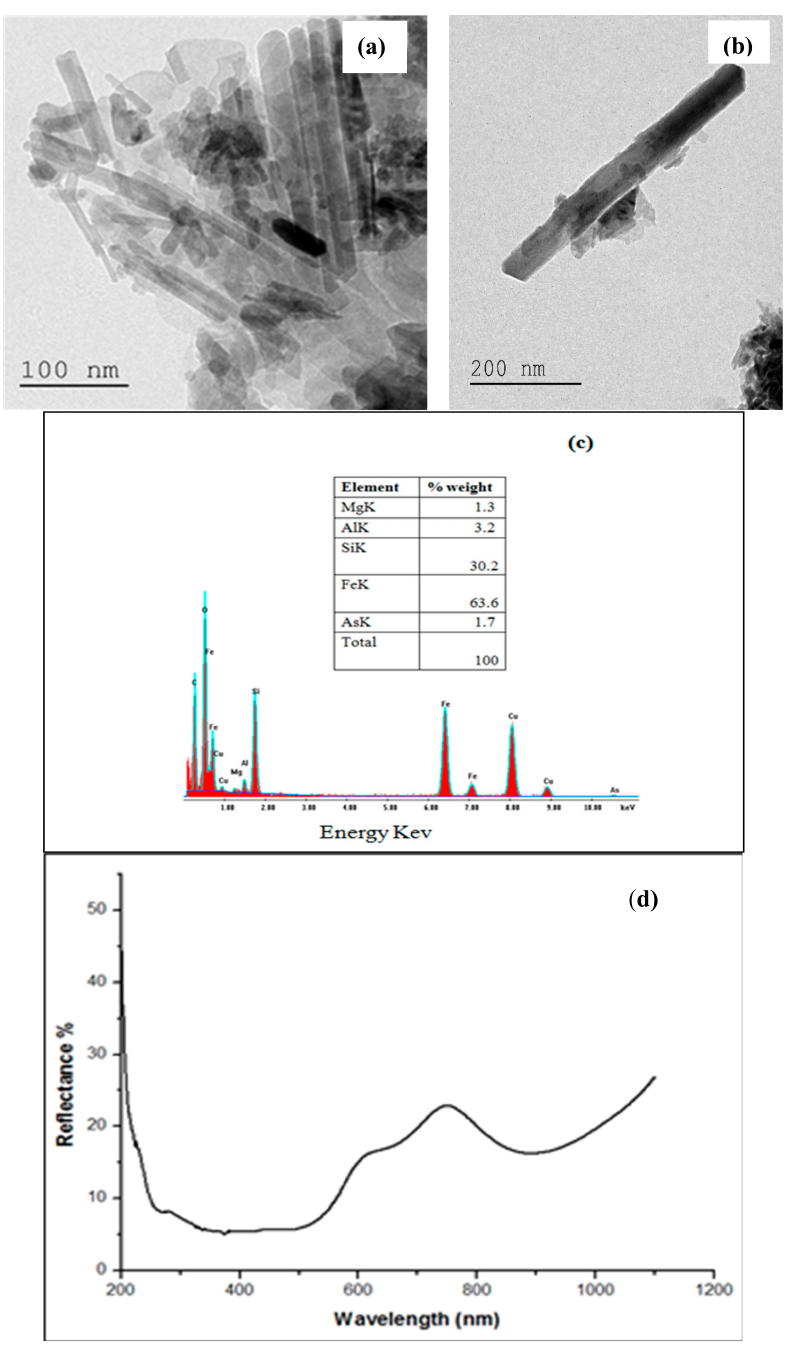
Figure 2. TEM micrographs at different scales: ( a ) 100 nm and ( b ) 200 nm; ( c ) EDX spectrum; ( d ) DRS of the